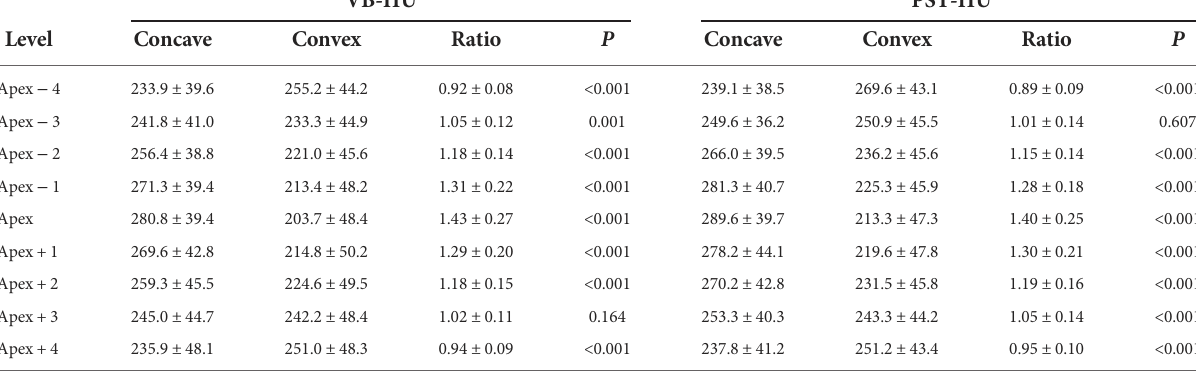
TABLE 3 VB-HU and PST-HU within the concave and convex side of the major curve and its asymmetric ratio. VB-HU